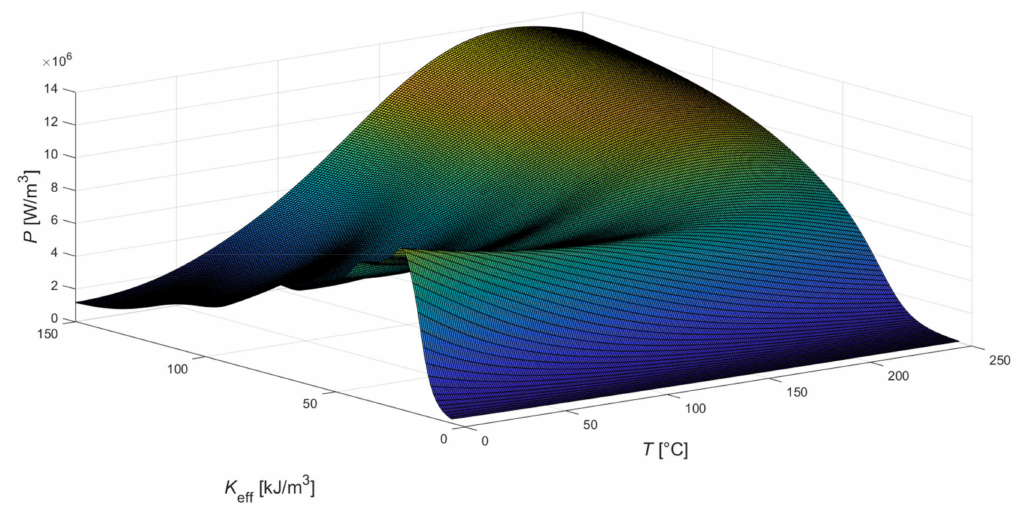
Figure 18. Heating power P dependence on temperature T, and anisotropy constant K eff of the magnetic fluid at field parameters f = 281 kHz and H = 7.83 kA/m.